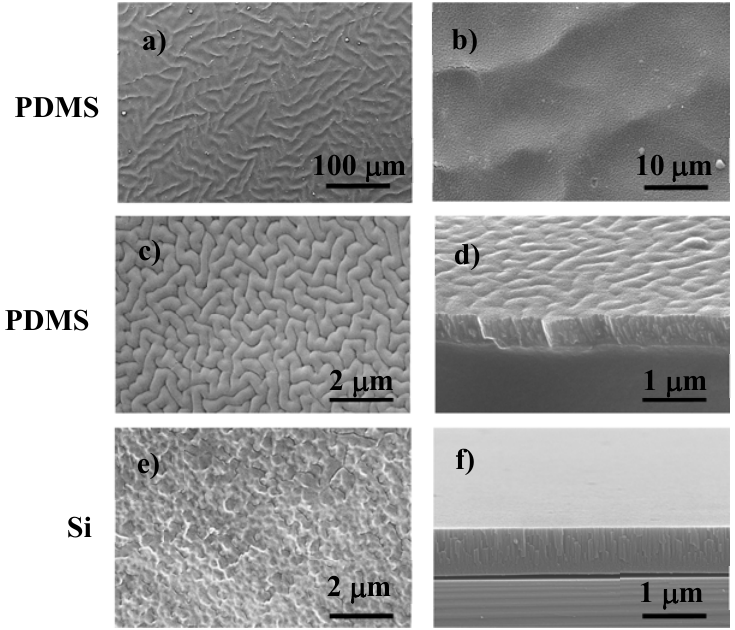
Figure 2. SEM micrographs of poly(amide) (PA) thin film deposited on PDMS: ( a ) N3, ( b) N2, ( c ) N1 surface, and ( d ) N1 cross ‐ section morphology. The same thin film (N1) deposited onto Si: ( e ) surface and f ) cross ‐ section morphology.